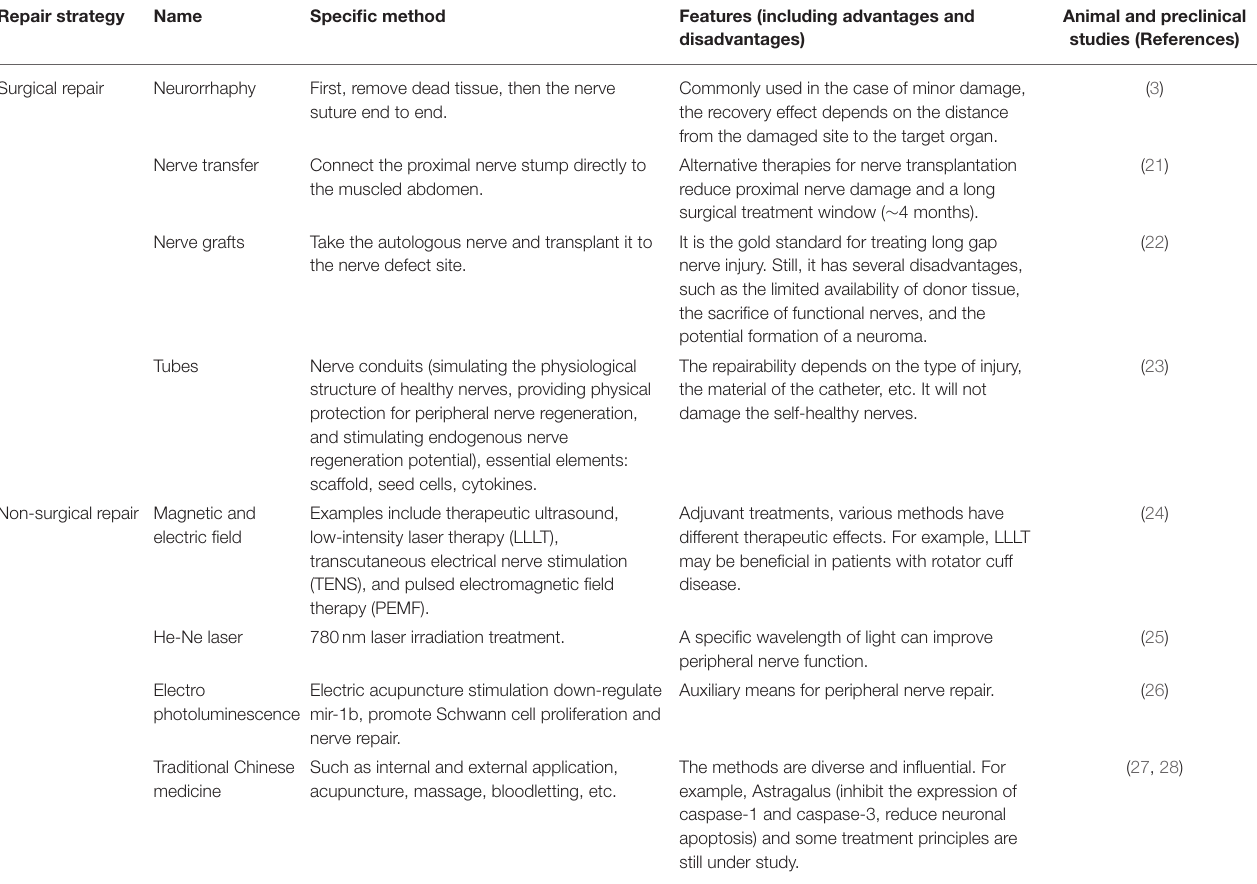
TABLE 2 | Repair strategies of peripheral nerve injury